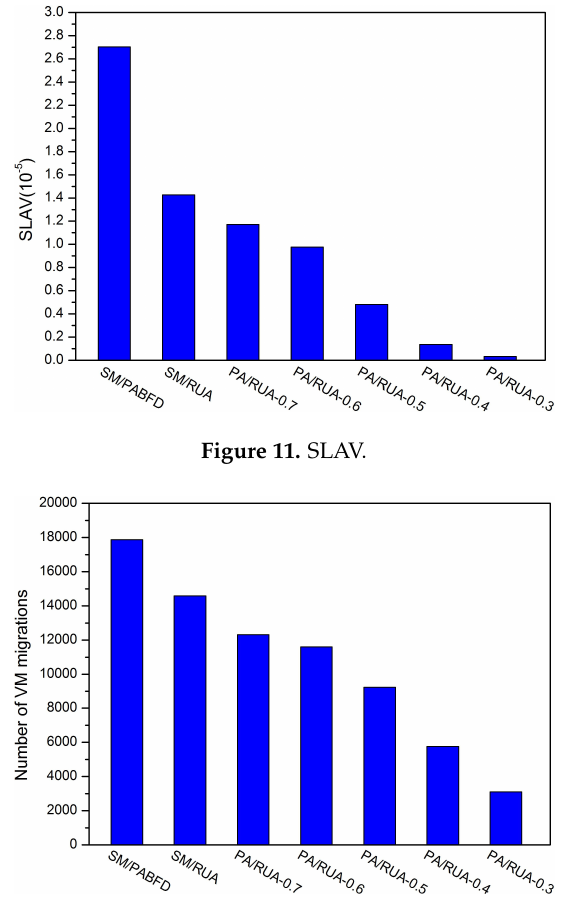
Figure 12. The number of VM migrations.